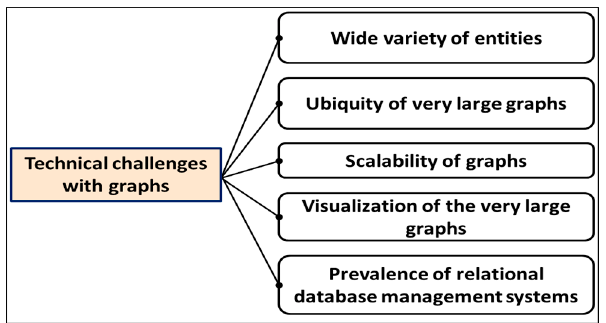
Figure 49. Technical challenges with the graph’s handling/processing.